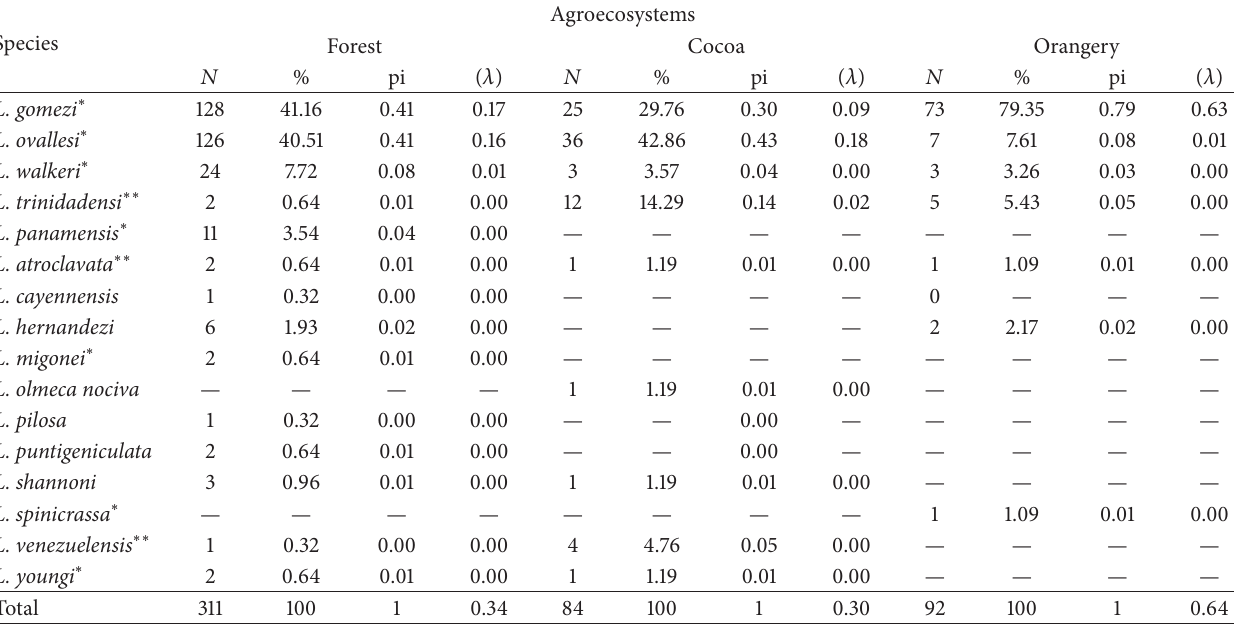
Table 2: The species abundance in the agroecosystems